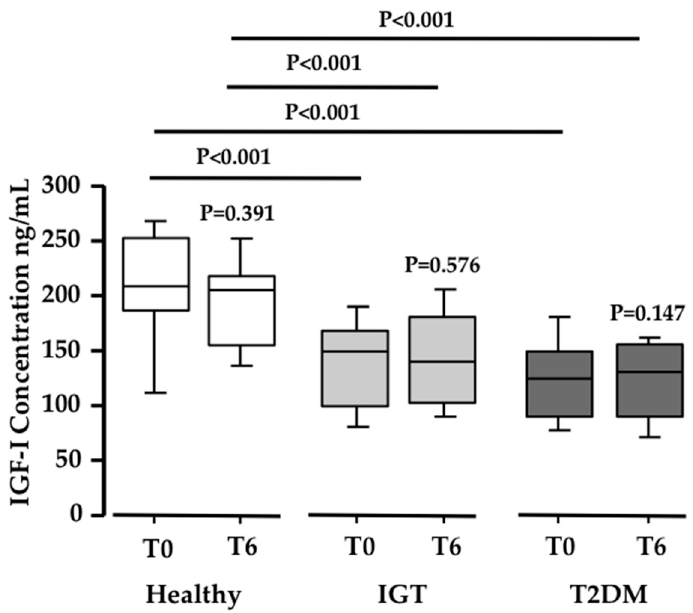
Figure 4. Changes in IGF-1 levels. Box-plot diagram showing the significant decrease in IGF1 concentration (ng/mL) in IGT and T2DM volunteers when compared to healthy subjects ( N = 20; 20; 19 respectively; P ≤ 0.0005).